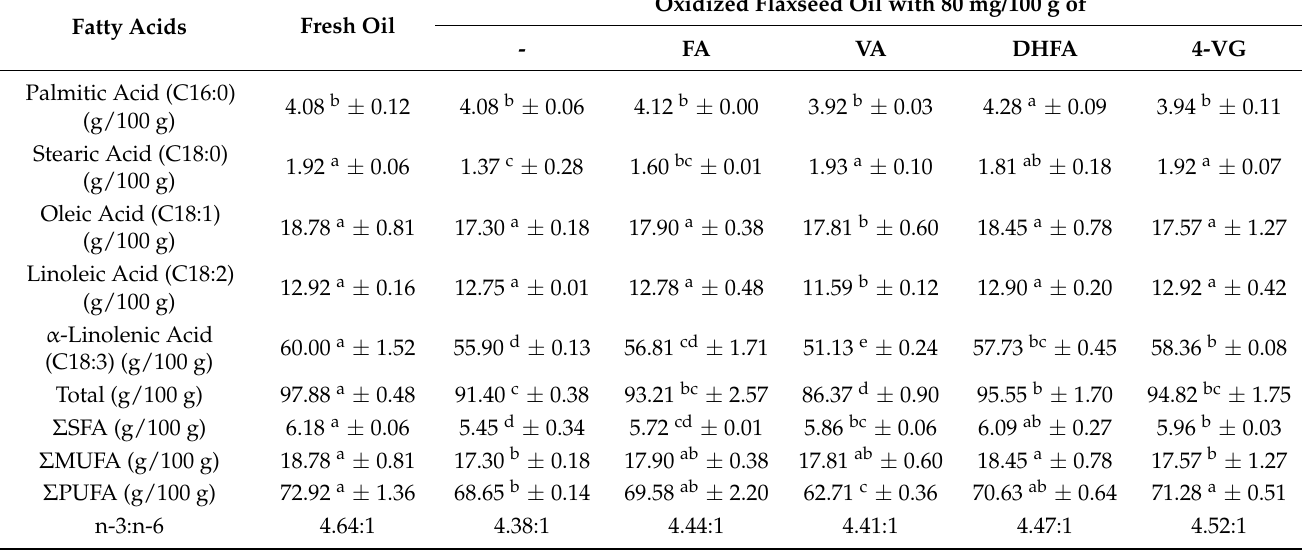
Table 3. Fatty acid composition (x ± SD) of fresh cold-pressed flaxseed oil and oxidized at 60 ◦ C without and with phenolic